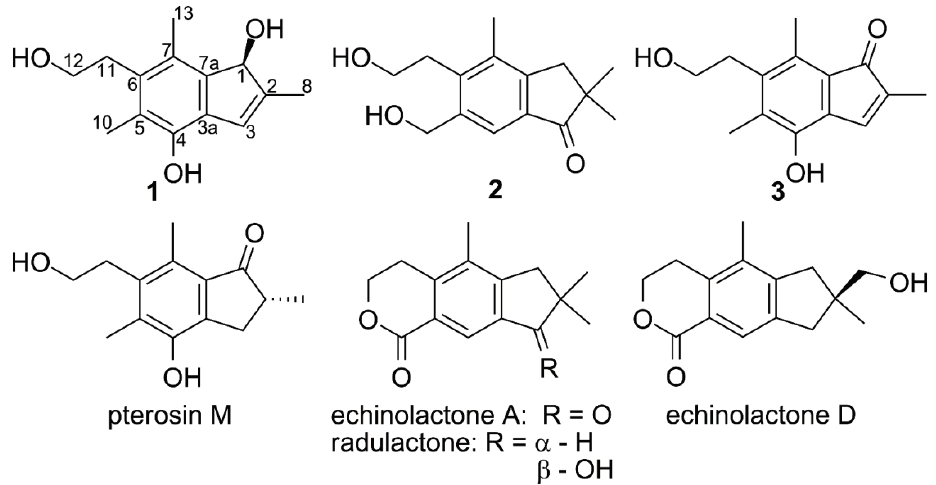
Figure 1. Structures of compounds 1 – 3 , pterosin M, radulactone, echinolactone A and